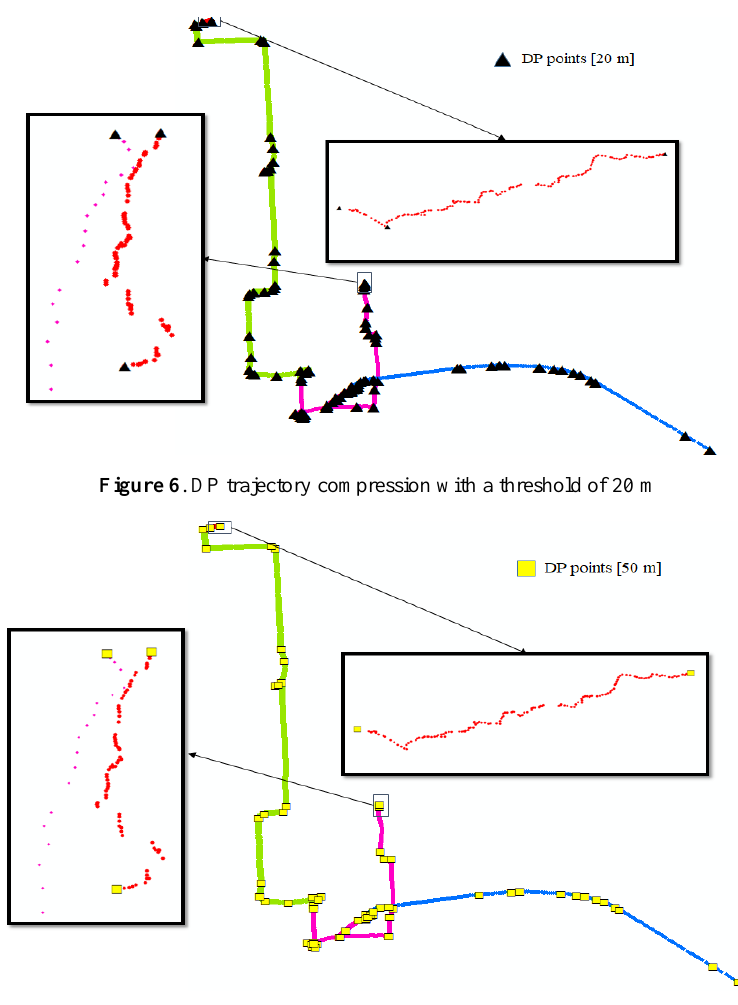
Figure 7 . DP trajectory compression with a threshold of 50 m